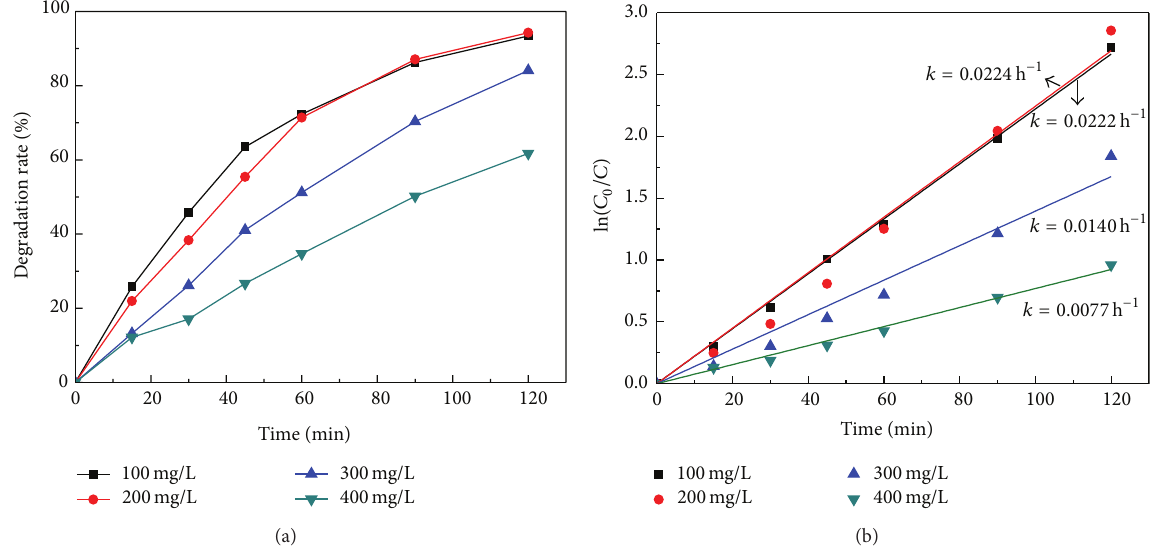
Figure 7: (a) Electrocatalytic performance of the sample in different initial concentration of phenol; (b) pseudo-first-order linear plots of ln (𝐶 0 /𝐶) versus time for the degradation kinetics of phenol at electrolytic voltage of 12V and BQP dosage concentration of